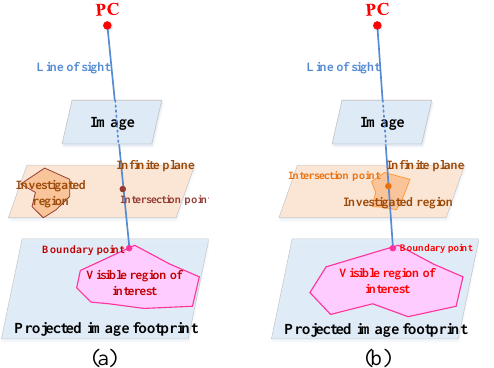
Figure 7. The suitability analysis of available images for the texturing of an extracted surface In the second step, the parts of the extracted surfaces which are occluding/being occluded by other surfaces within appropriate images are identified. This occlusion detection is implemented based on the visibility of boundaries of the extracted surfaces within those images. This visibility analysis is performed by intersecting the line segments between the perspective center of a given image and individual boundary points of an extracted surface with all surfaces that can be textured using that image. If the intersection point is outside the investigated region, the boundary point is not occluding/being occluded by that surface within the image in question. However, if the intersection point happens to be inside the investigated region, either the boundary point is occluded by the intersection points or the boundary point is occluding the intersection point (Figure 8).